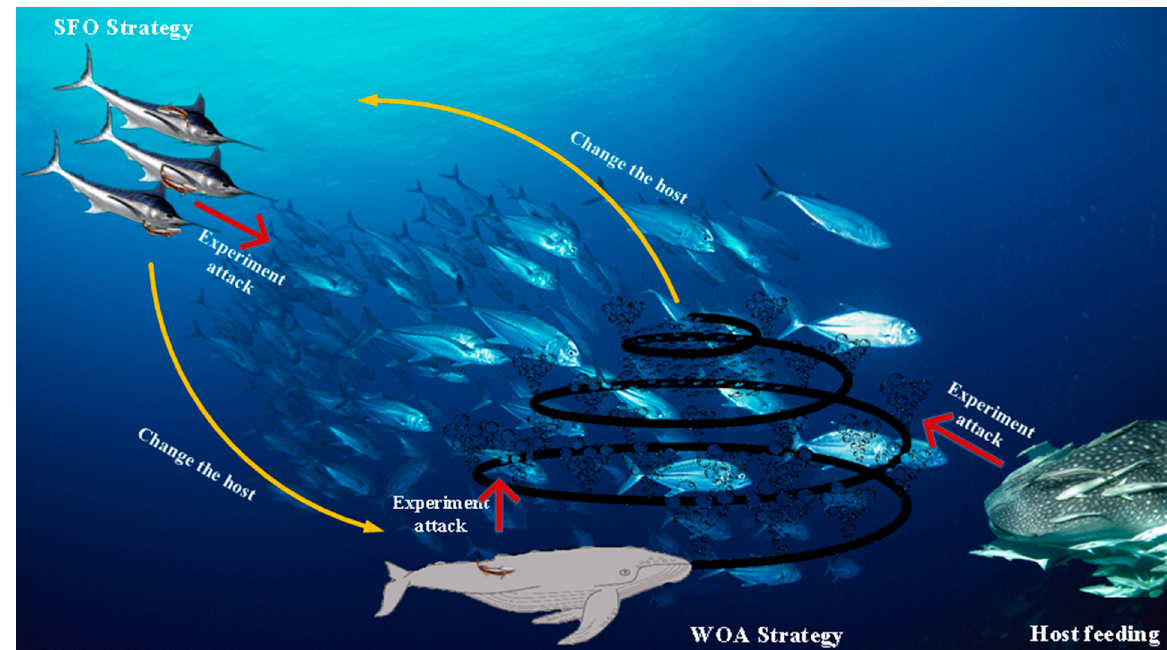
Figure 1. The different process of ROA.